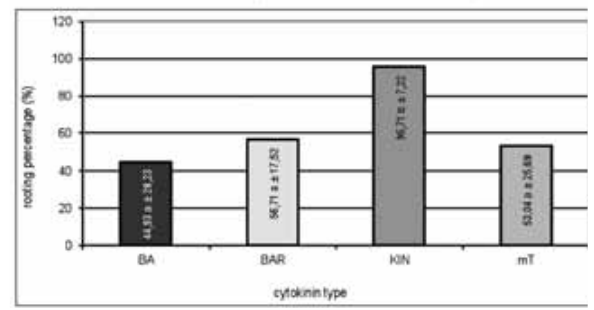
Figure 7. Rooting percentages of in vitro Nidularium ’Kertész Jubileum’ plants cultured on different type of